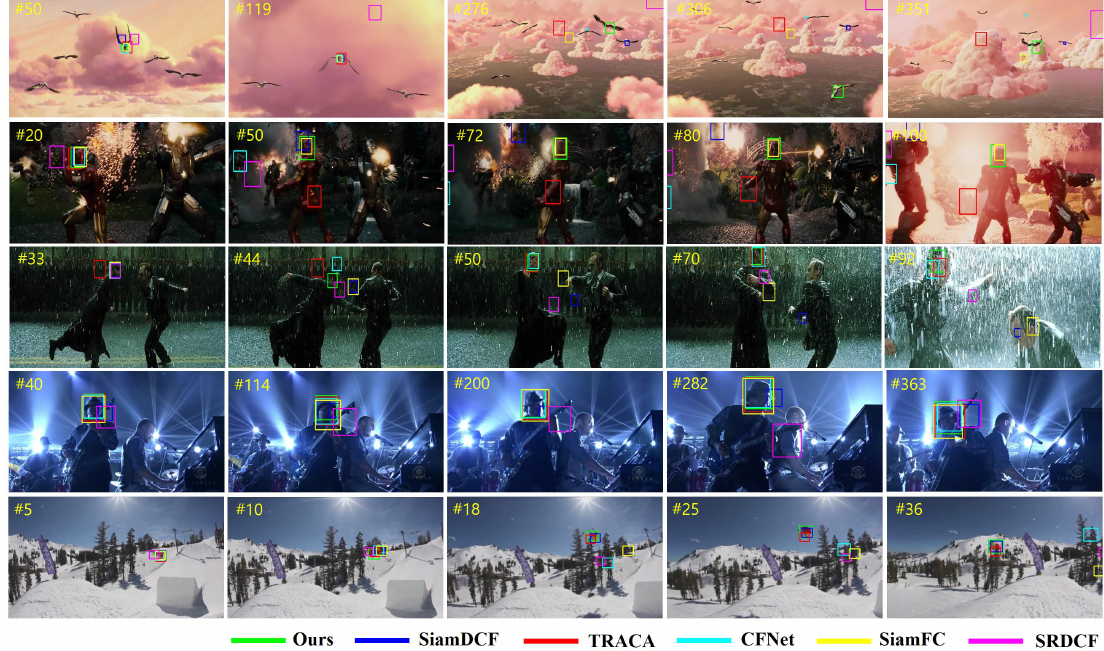
Figure 13. Qualitative comparison of our trackers with five trackers on OTB2015 dataset (from top to down are Bird1 , Ironman , Matrix , Shaking , and Skiing ). Our trackers achieve the best visual results with existing trackers in several challenging